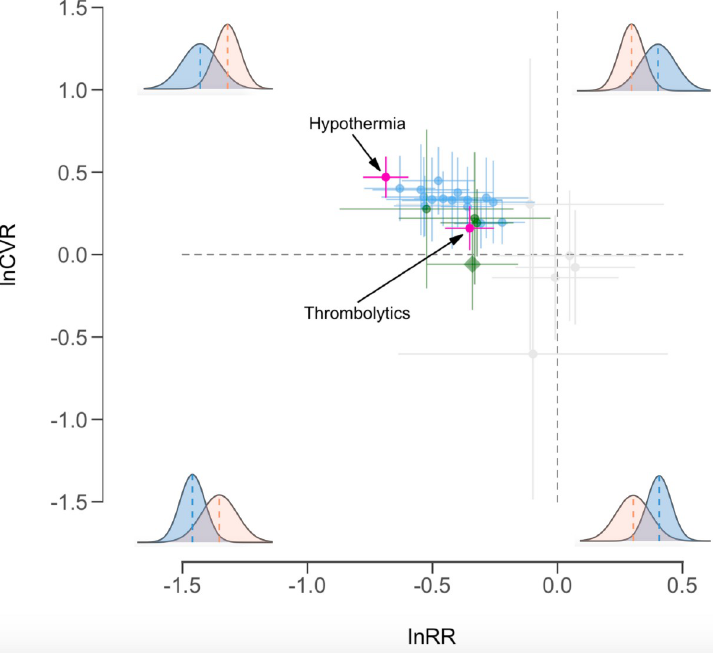
Fig 3. Categorization of treatment effects based on mean efficacy (lnRR) and interindividual variability in efficacy (lnCVR). Estimates (circles) represent unconditional (marginalized), treatment-specific means (lnRR), variability (lnCVR), and their 95% CIs (solid lines) obtained from MLMR models. Treatments that significantly reduce infarct volume (negative lnRR) without significantly affecting the variation are highlighted green, with citicoline indicated by a diamond as the only treatment to significantly reduce infarct volume and also have a negative point estimate of lnCVR. Treatments that significantly reduce infarct volume and increase interindividual variability (positive lnCVR) are highlighted blue. The effects of hypothermia (most negative and positive mean and variability estimates, respectively) and thrombolytics (which include the only regulatory-approved treatment) are highlighted in pink. Histograms show the relationship of the mean and variance in infarct volume between control (orange) and treatment (blue) groups in each quadrant of the graph. The data underlying this figure can be found at https://doi.org/10.6084/ m9.figshare.14527317.v4. CI, credible interval; lnCVR, log coefficient of variation ratio; lnRR, log response ratio; MLMR, multilevel meta-regression.